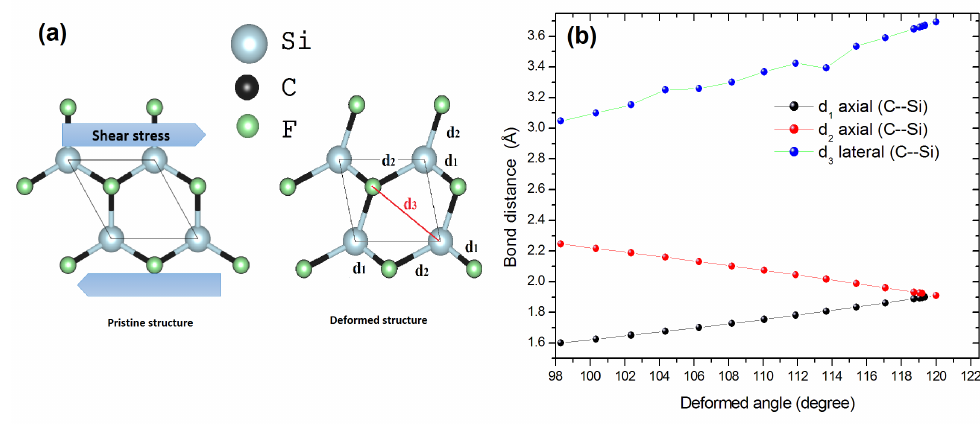
Figure 4. ( a ) Schematic representation of the pristine and strained (deformed) structure of CF 2 Si monolayer. ( b ) Calculated strain dependence of C–Si bond distances. d 1 , d 2 represent the axial bonds and d 3 the lateral bonds.